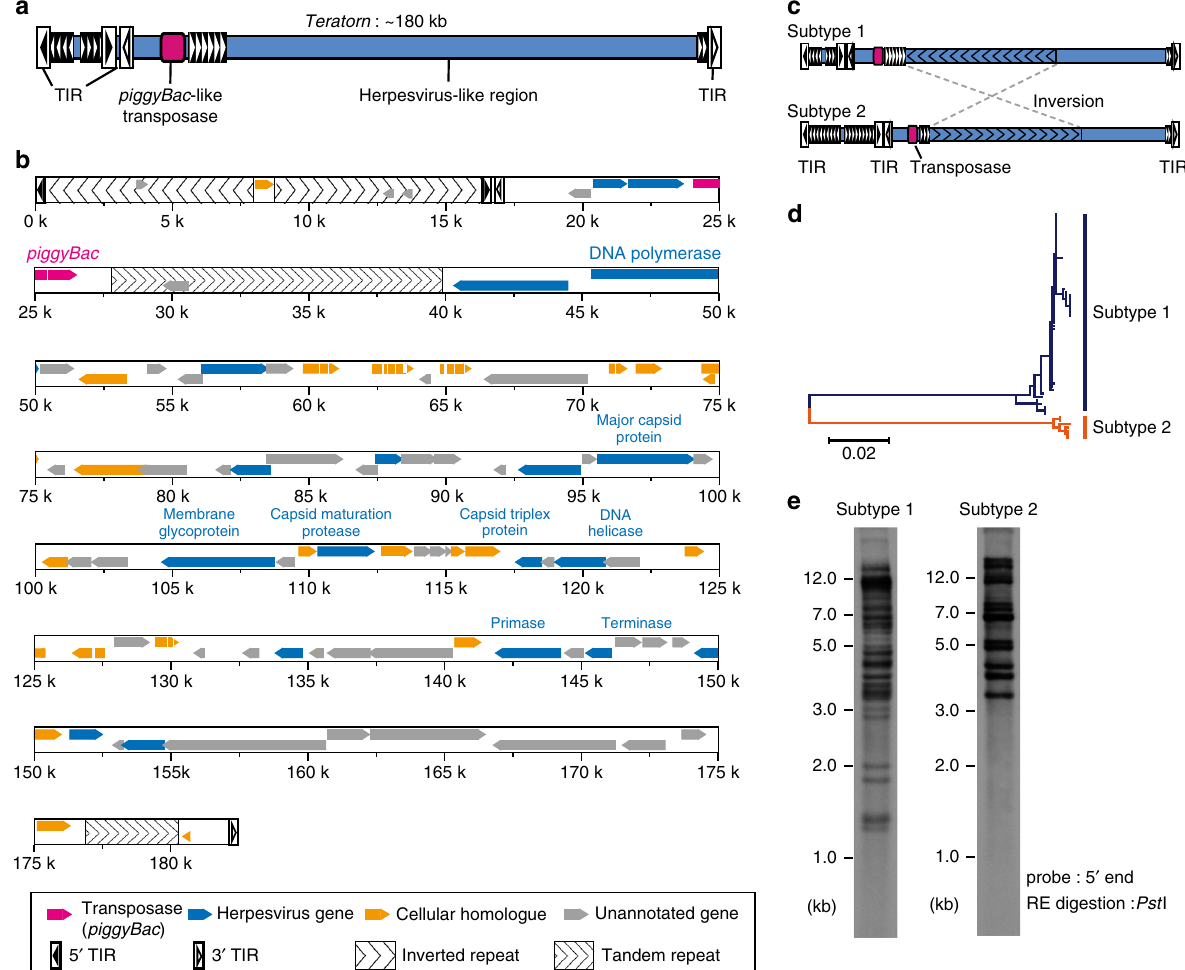
Fig. 1 Sequence characteristics of Teratorn . a The overall structure of Teratorn . b Gene map of the subtype 1 Teratorn copy (73I9; named from the BAC clone ID). Predicted genes are classi fi ed into four categories depicted by colored arrowheads ; magenta , piggyBac -like transposase gene; blue , herpesvirus-like genes; yellow , cellular homologues; gray , unannotated genes. Terminal inverted repeats (TIRs) of piggyBac -like transposon are depicted by boxed triangles . c Comparison of the whole structure of subtype 1 and subtype 2 Teratorn . d Neighbor-joining tree of all Teratorn transposase copies in the genome of medaka Hd-rR inbred strain. Note that they are separated into two clusters. The scale bar represents the number of substitutions per site. e Southern blot displaying individual Teratorn insertions in the genome of medaka Hd-rR inbred strain. The ~300-bp 5 ′ terminal region of Teratorn of each subtype was